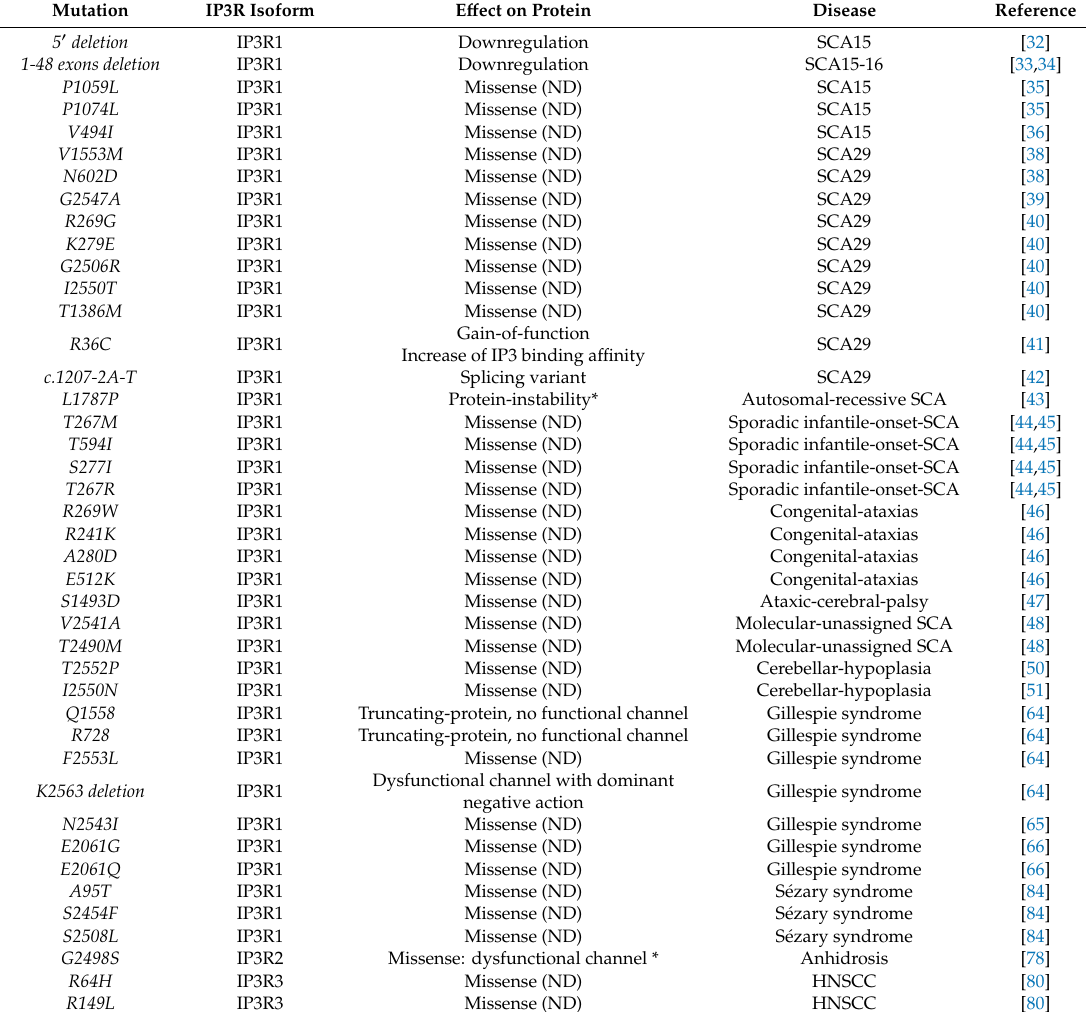
Table 2. Spectrum of IP3Rs mutations identified in